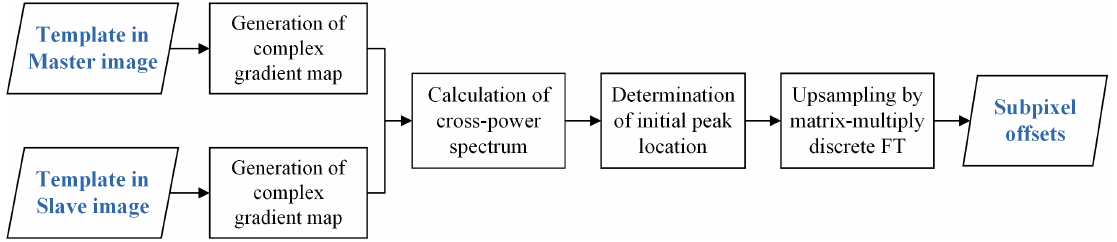
Figure 2. Flowchart of the locally upsampled gradient correlation (LUGC)